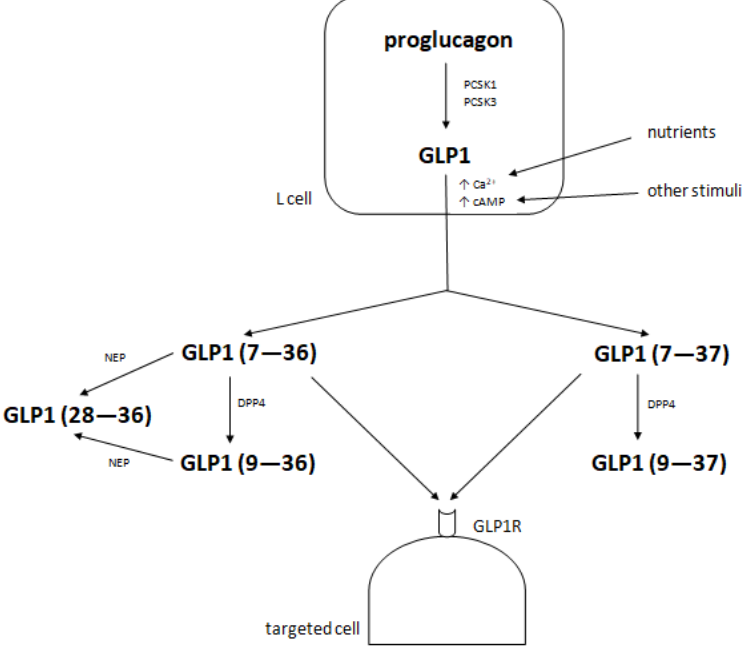
Figure 2. The metabolism of GLP1. A description is given in the text